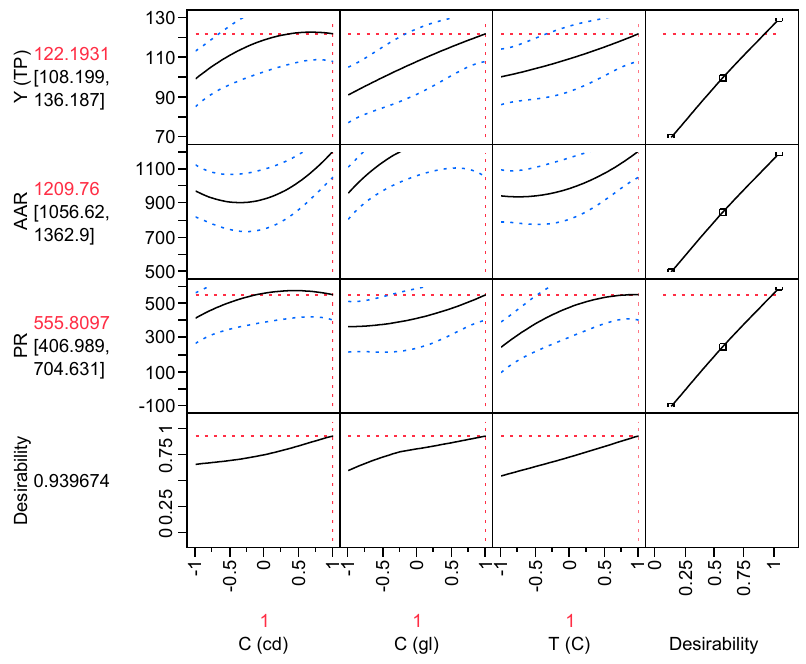
Figure 4. Prediction profiler displaying the overall desirability of the model, following adjustment of the independent variable at their optimal values. Extractions of oak acorn husks were carried out under stirring at 600 rpm, for 180 min and a liquid-to-solid ratio of 50 mL g –1 .